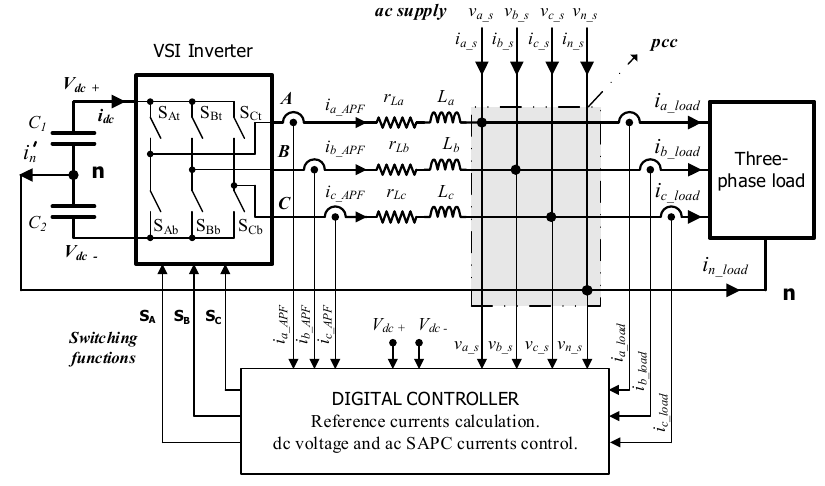
Figure 7. Block diagram of the power system under consideration.